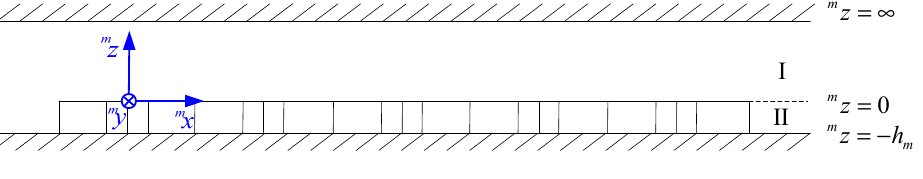
Figure 3. Analysis model of the Halbach magnet array.